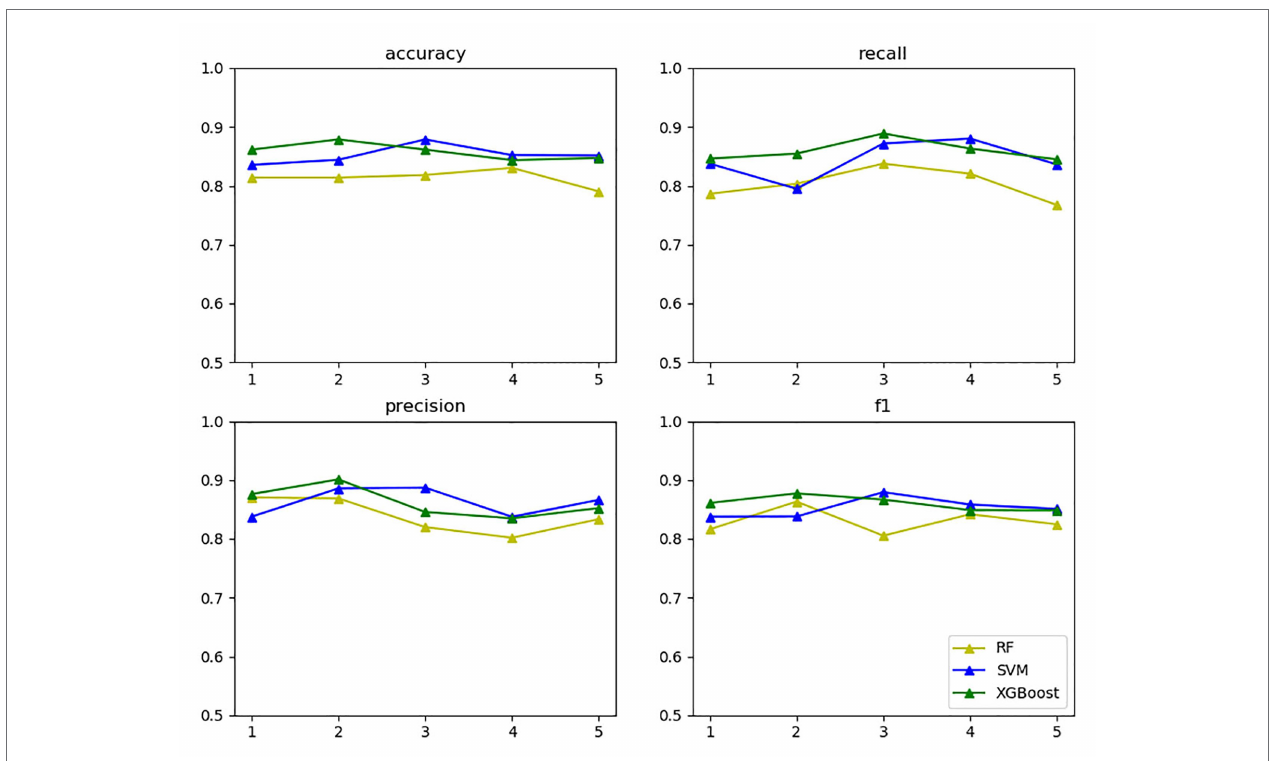
FIGURE 11 | Three model